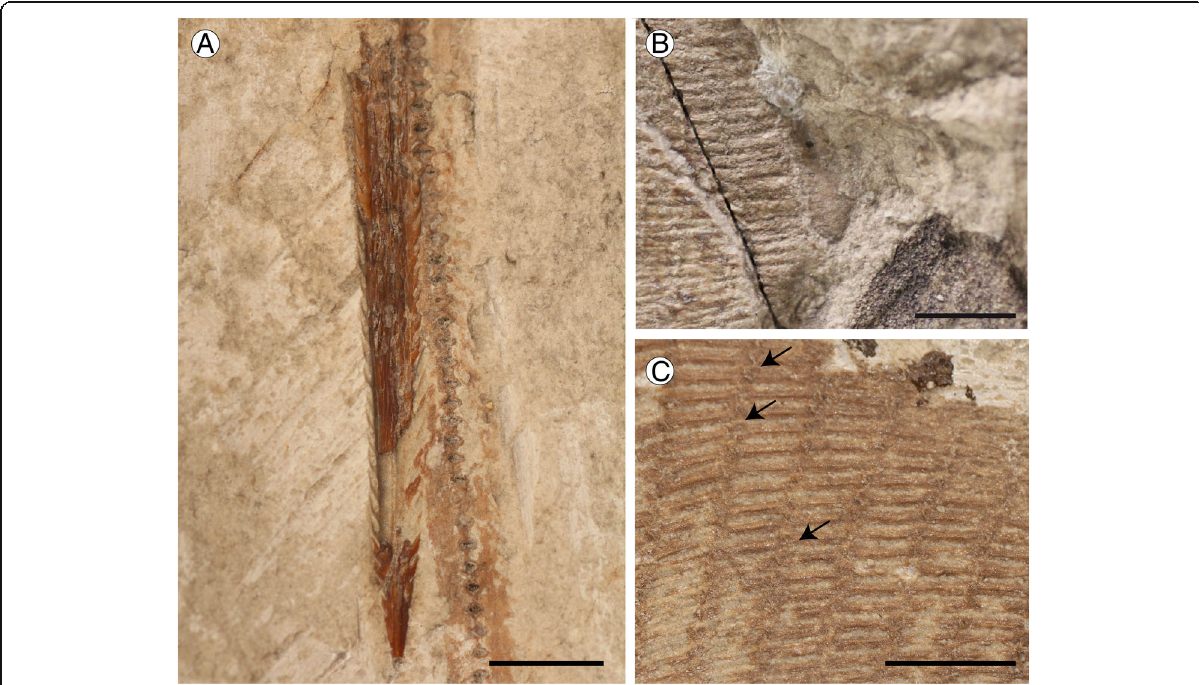
Fig. 4 Promyliobatis gazolai from the Eocene of the Bolca Lagerstätte. a Detail of the tail sting of MSNPV 14620. b Close up of the single and non-fragmented mesopterygium in MCSNV VII.B.90/91. c Detail of the pectoral radials in MCSNV VII.B.90/91; note the crustal calcification of radials and the interradial joints indicated by arrows. Scale bars = 10